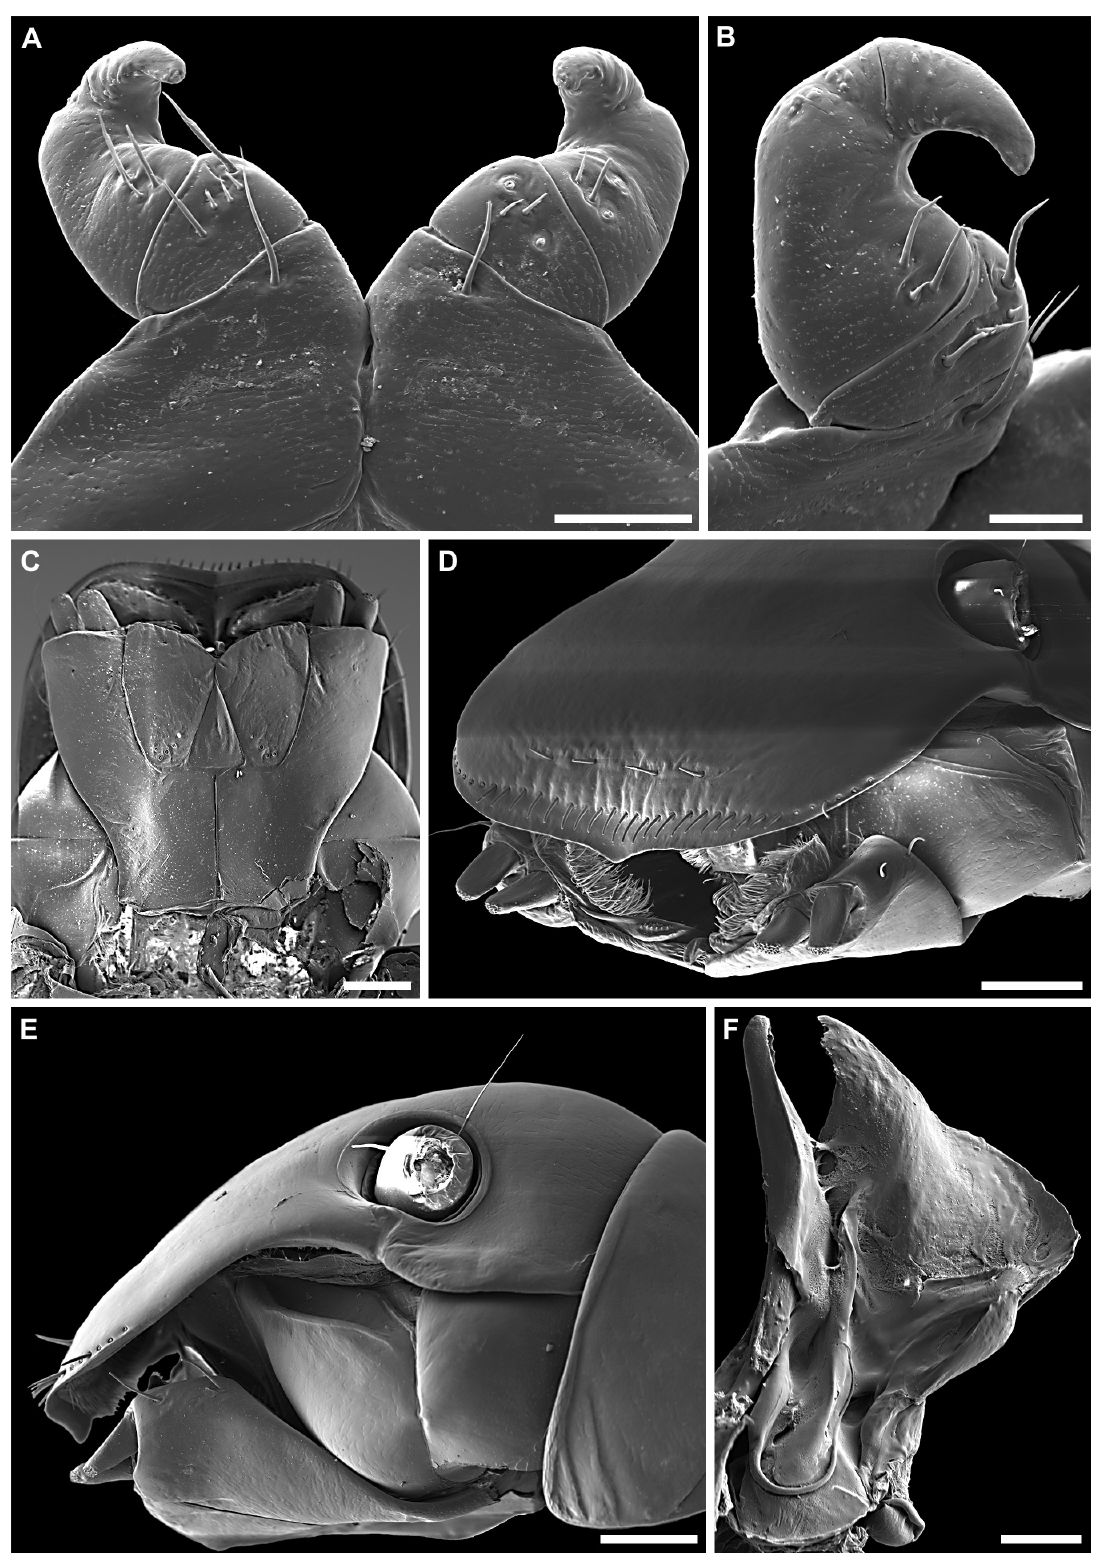
Fig. 48. Leucogeorgia turbanovi sp. nov., paratype ♂ from Pechalnaya Cave (SMNG). A . Leg-pair 1, anterior view. B . Left leg 1, lateral view. C . Head, ventral view. D . Head, anterolateral view. E . Head, lateral view. F . Left gonopods, mesal view. Scale bars: A, F = 0.1 mm; B = 0.05 mm; C–E = 0.2